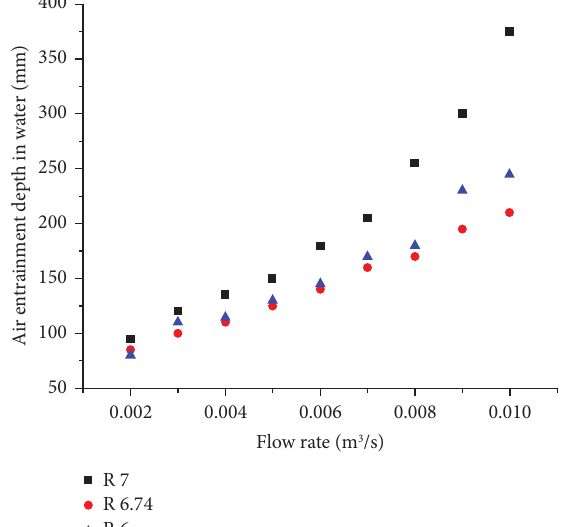
Figure 8: Air entrapment depth in water for different flow rates.